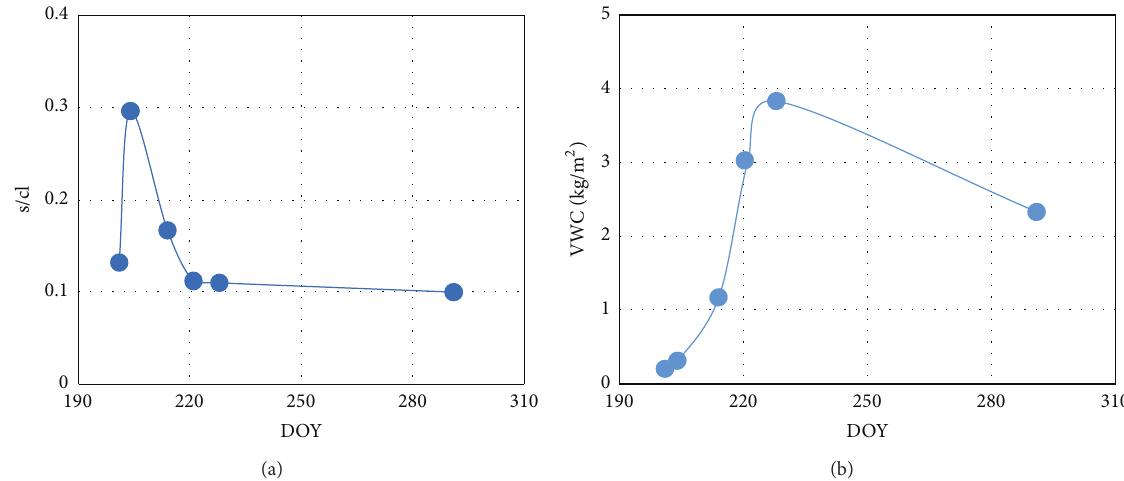
Figure 5: The change in s/cl (a) and VWC (b) with the sampling date. s/cl (the ratio of root mean square height and correlation length) denotes surface roughness parameter and VWC denotes vegetation water